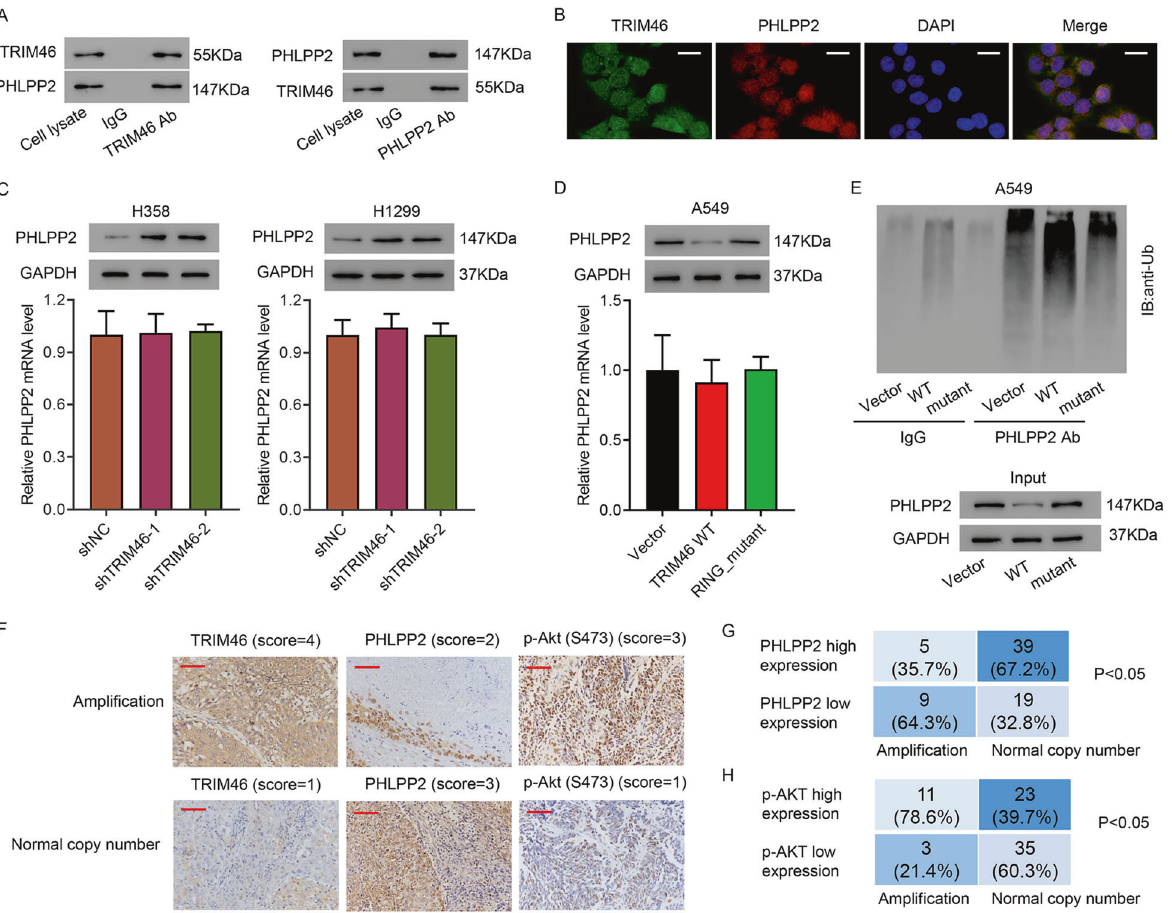
Fig. 5 TRIM46 interacted with PHLPP2 and promoted PHLPP2 ubiquitination in LUAD cells. A Co-IP assay of TRIM46 and PHLPP2 in H358 cells. B Immuno fl uorescence assay of TRIM46 and PHLPP2 in H358 cells (scale bar: 20 μ m). C qPCR and immunoblot analysis of PHLPP2 expression in both H358 cells and H1299 cells with TRIM46 silence. D Analysis of PHLPP2 expression in A549 cells transfected with WT-TRIM46, RING-mutant TRIM46, or vector. E IP analysis of the ubiquitination of PHLPP2 in A549 cells transfected with WT-TRIM46, RING-mutant TRIM46, or vector. F Immunohistochemical staining of TRIM46, PHLPP2, and p-AKT in cohort 1 (scale bar: 100 μ m). G , H Statistical analysis of LUAD tissues under different staining conditions in cohort 1. Results were presented as the mean ± standard error ( n = 3). Independent experiments were repeated three